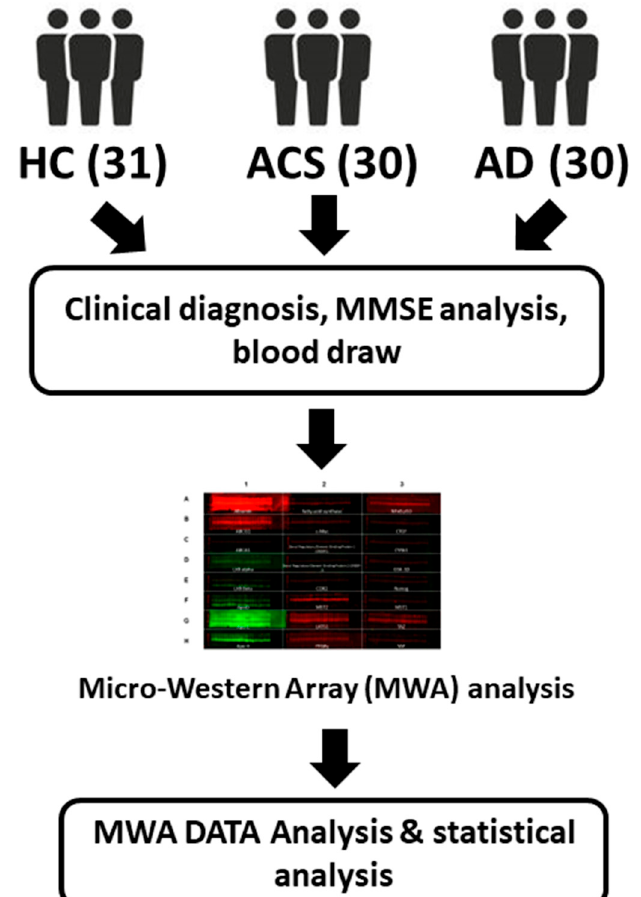
Figure 1. Experimental design. 31 healthy control (HC), 30 patients with AD (AD) and 30 adult children of AD patient study (ACS) were recruited in this study and were being examined with clinical doctors for health status, MMSE, ApoE ε 4 expression, and blood draw. The serum samples were then being processed and analyzed with Micro-Western Array (MWA). The protein expression levels was then analyzed for correlation with age or MMSE.